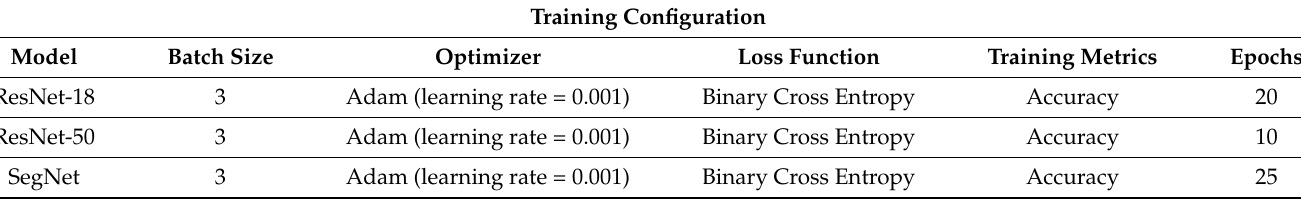
Table 5. Training